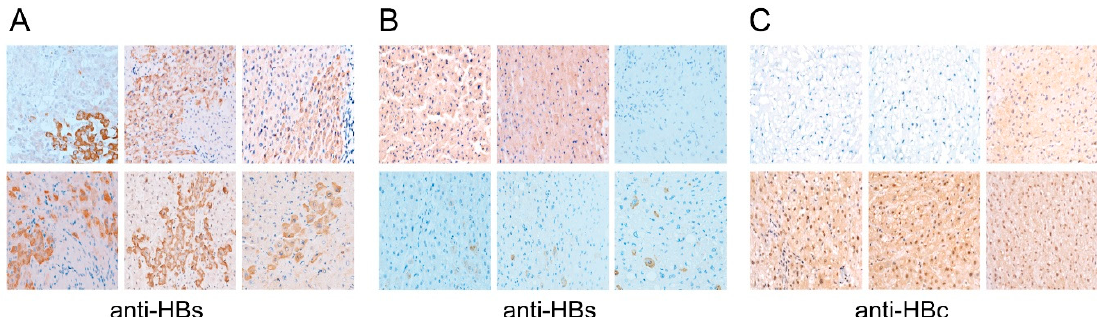
Figure 3. Distinct types of tissue distribution for HBsAg and HBcAg. ( A , B ) Tissue distribution patterns of HBsAg, ( A ) the clustered distribution pattern; (( B ), upper left and middle) the diffuse distribution pattern; (( B ), upper right) negative control; and (( B ), lower panels) the scattered distribution pattern. ( C ) Tissue distribution patterns of HBcAg; (( C ) upper left and middle) negative controls; (( C ) upper right) predominantly cytoplasmic distribution; and (( C ) lower panels) predominantly nuclear distribution. Antibodies used were given at the bottom: Anti-HBs: Antibodies against HBsAg; anti-HBc: Antibodies against HBcAg.